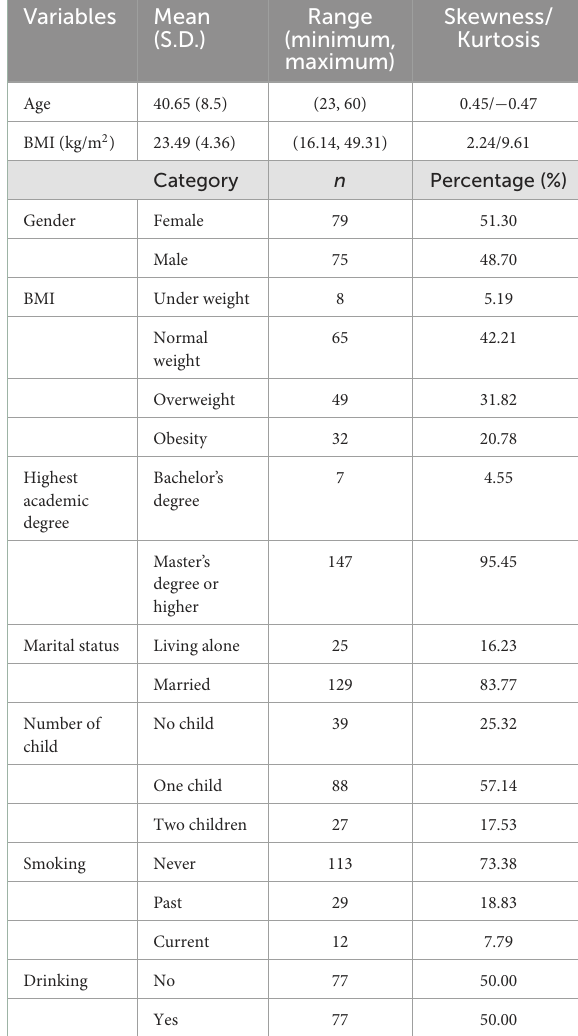
TABLE 1 Characteristics of the